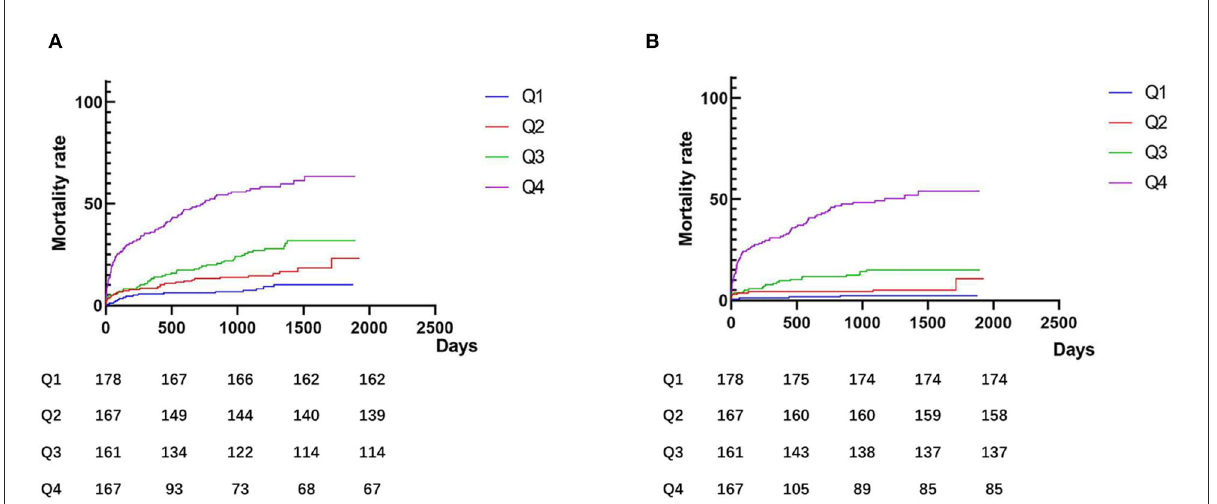
FIGURE2 Kaplan–Meier curves according to groups of admission D-dimer levels. (A) Major adverse composite cardiovascular events (MACEs); and (B) All-cause death. Q1: ≤ 0.3 µ g/L; Q2: 0.31–0.46 µ g/L; Q3: 0.47–0.96 µ g/L; and Q4: > 0.96 µ g/L.